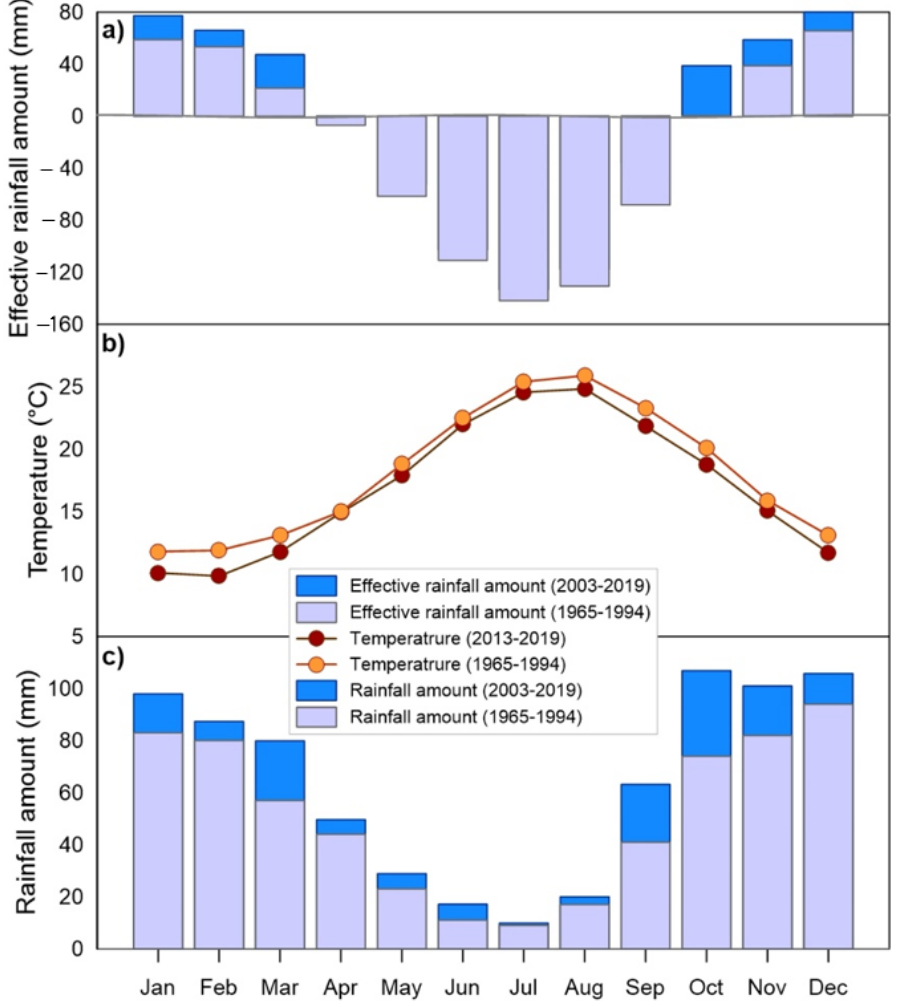
Figure 3. Hydrological balance. Monthly variation of effective rainfall amount ( a ), air temperature ( b ), and rainfall amount ( c ) at Stromboli.